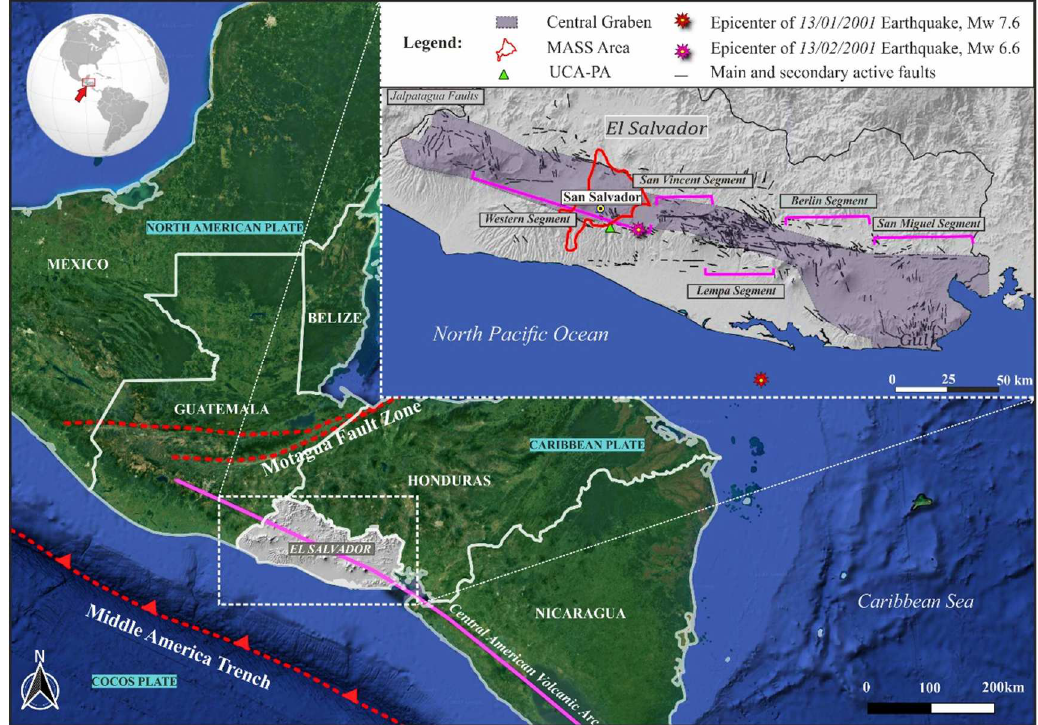
Figure 1. The geographical setting of El Salvador region. The inset shows the faults distribution throughout the country and epicentres of the two strong earthquakes (13 January and 13 February 2001). The red arrow indicates the study area (after [37,38],